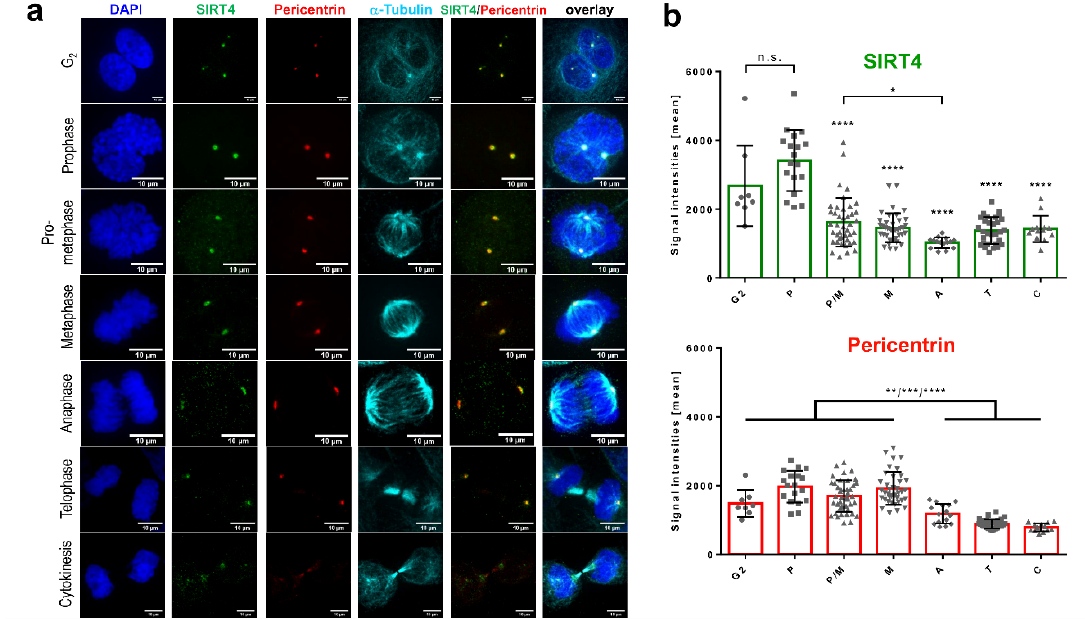
Figure 1. Centrosomal localization pattern of SIRT4 during G 2 /M progression. ( a ) Endogenous SIRT4 was detected in HeLa cells in G 2 and subsequent mitotic stages using a polyclonal antibody against SIRT4 (sc-135053; Santa Cruz Biotechnology, Heidelberg, Germany) and spinning disk microscopy. Antibody staining against Pericentrin and α -tubulin was employed to visualize centrosomes and microtubules, respectively. DAPI was used to detect DNA. Bar: 10 µm. ( b ) Quantification of centrosomal SIRT4 and Pericentrin levels during G 2 /M progression. Endogenous SIRT4 and Pericentrin were detected in HeLa cells as indicated above. Shown are mean signal intensities (±S.D.) which were analyzed using ImageJ software (v1.49k; Materials and Methods). Numbers of cells analyzed per cell cycle phase: G 2 , n = 8; P, prophase, n = 17; P/M, prometaphase, n = 42; M, metaphase,